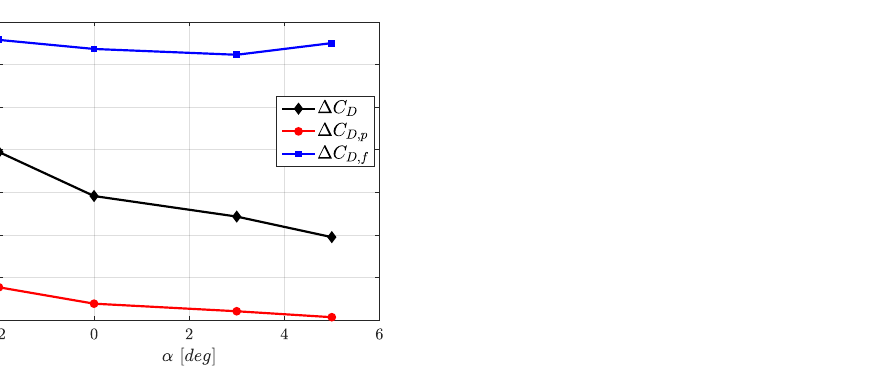
Figure 13. Drag reduction rate vs. angle of attack. The largest drag reduction is achieved in cruise condition.